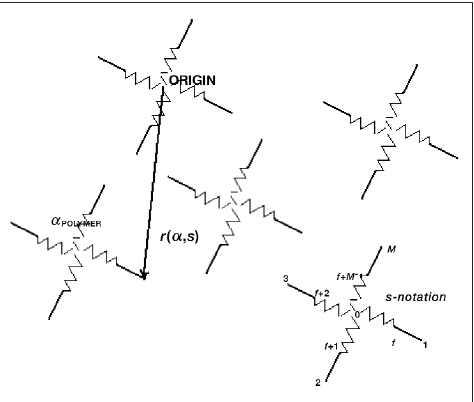
Fig. 6. Positional parametrization of starblock co- polymers. Copolymer melt is composed of starblock copolymers made up of alternating blocks consist- ing of f A -type and (1 − f ) B -type monomeric frac- tions. Positional vector defining relative position of various branches of the i th copolymer is defined in terms of polymer number and branch number. Space function is piecewise continuous with discontinu- ities at integer